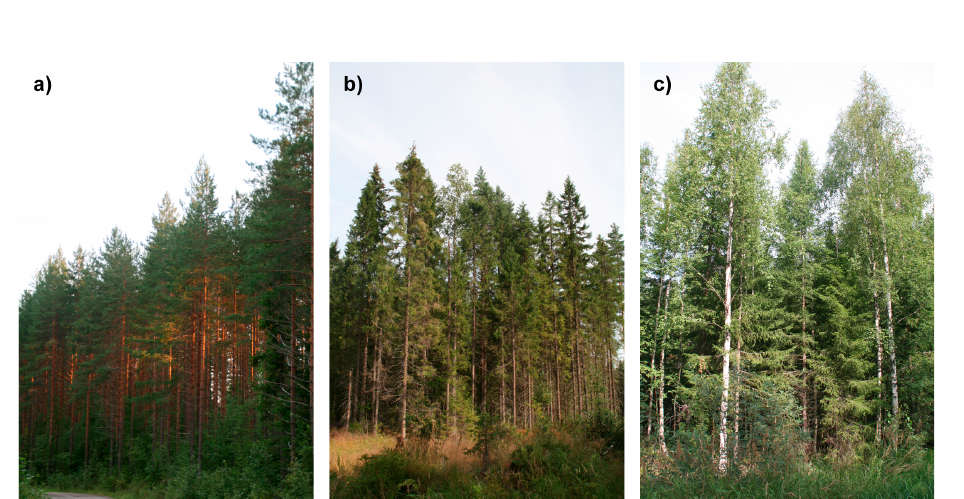
Fig. 6. Densely forested areas within 5km of the Hyyti¨al¨a site: a) Scots pine designated by the Corine database as “coniferous forest”, (b) Spruce, designated by the Corine database as “coniferous forest”, and (c) Birch and conifers, designated by the Corine database as “mixed